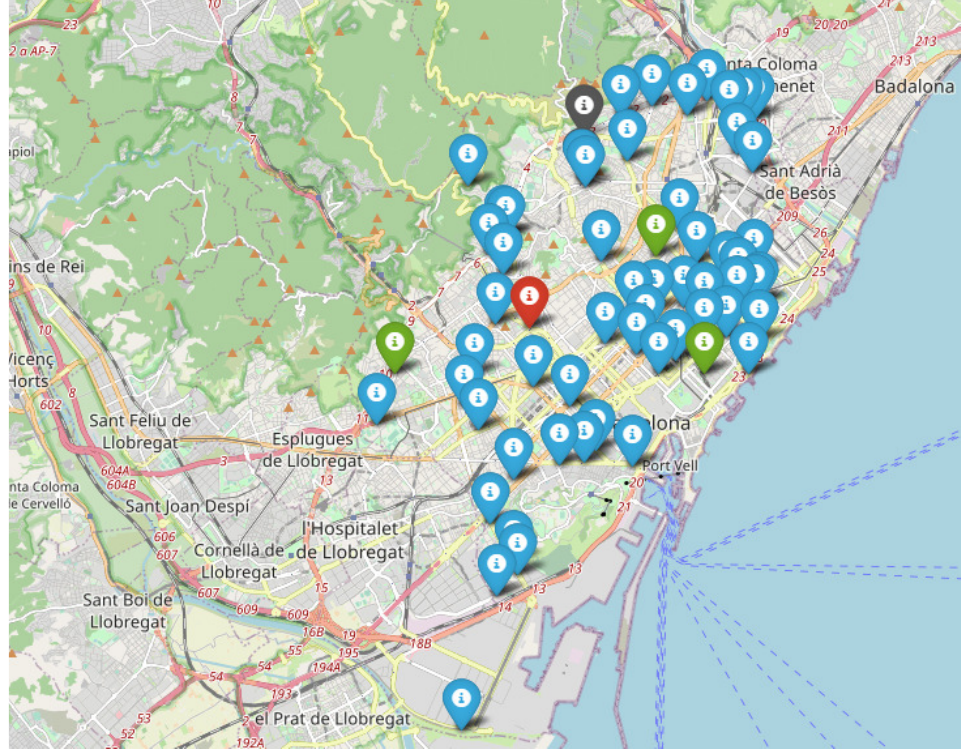
Figure 3. Map of the waste containers and depots used for our experimental